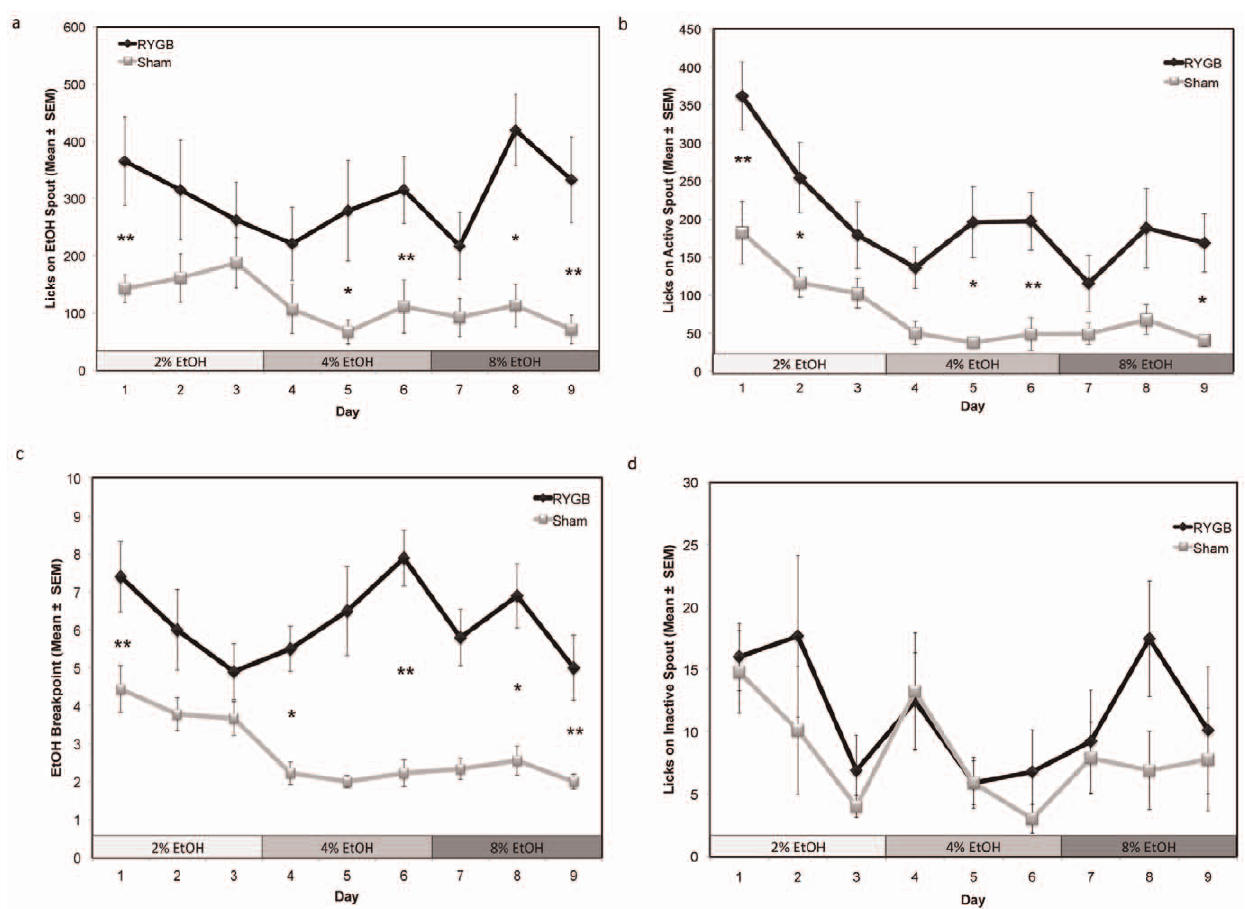
Figure 2. RYGB rats worked harder for, and consumed more alcohol during oral self-administration. a) EtOH intake, measured by the number of licks made on the spout containing ethanol during PR testing, was averaged and presented as Mean 6 SEM. RYGB rats made more licks for 2% (Day 1), 4% (Days 5–6), and 8% EtOH(Days 8–9). b) Active spout licks, presented as Mean 6 SEM. RYGB rats made more licks on the active spout than Sham rats for 2% (Days 1–2), 4% (Days 5–6), and 8% EtOH (Day 9). c) The number of cycles completed by the rats (breakpoint) presented as Mean 6 SEM. RYGB rats displayed significantly higher breakpoints than Sham rats for 2% (Day 1), 4% (Days 4,6), and 8% EtOH (Days 8–9). d) Inactive spout licks, presented as Mean 6 SEM. There were no significant differences in the number of inactive licks made between RYGB and Sham